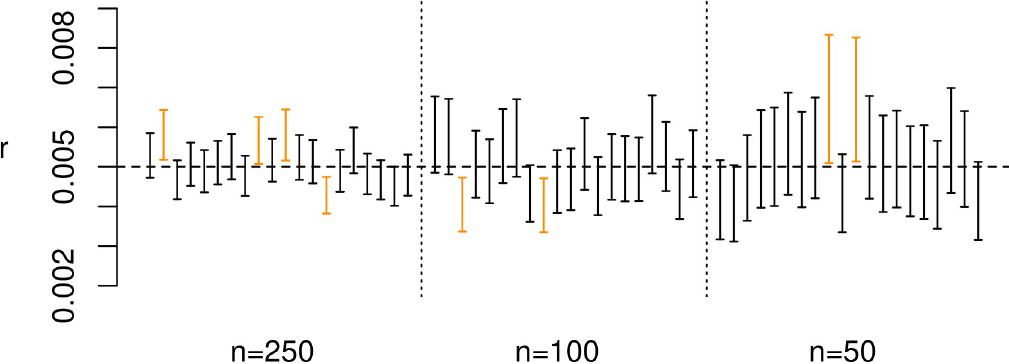
Fig 4. Results of experiment 3a. Error bar represents the estimated 90% HPD interval for each run; cases where the true parameters were not within the interval are displayed in orange.